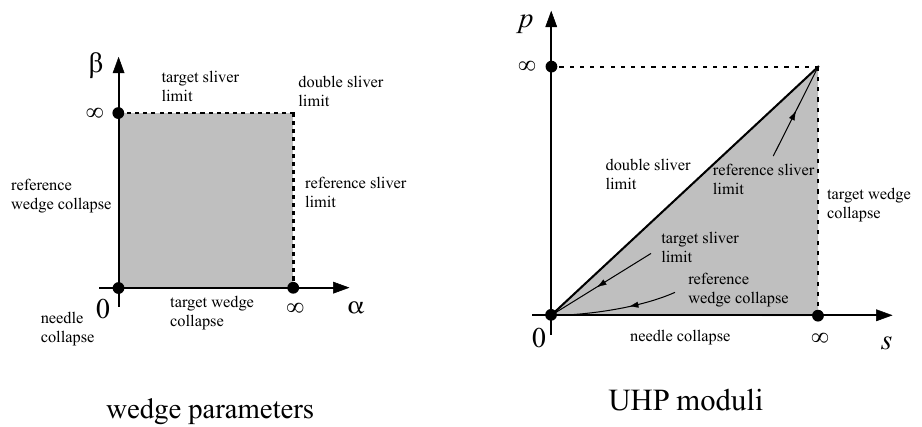
Figure 31 . Limits of (cid:13)ag-anti-(cid:13)ag